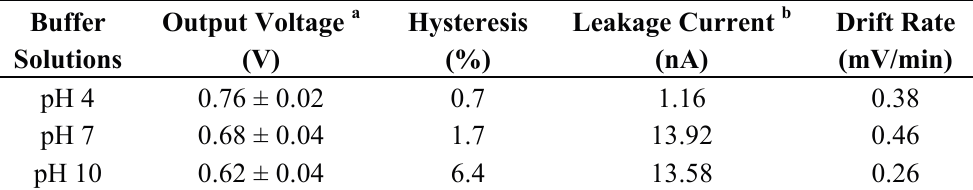
Table 1. Performance summary of the